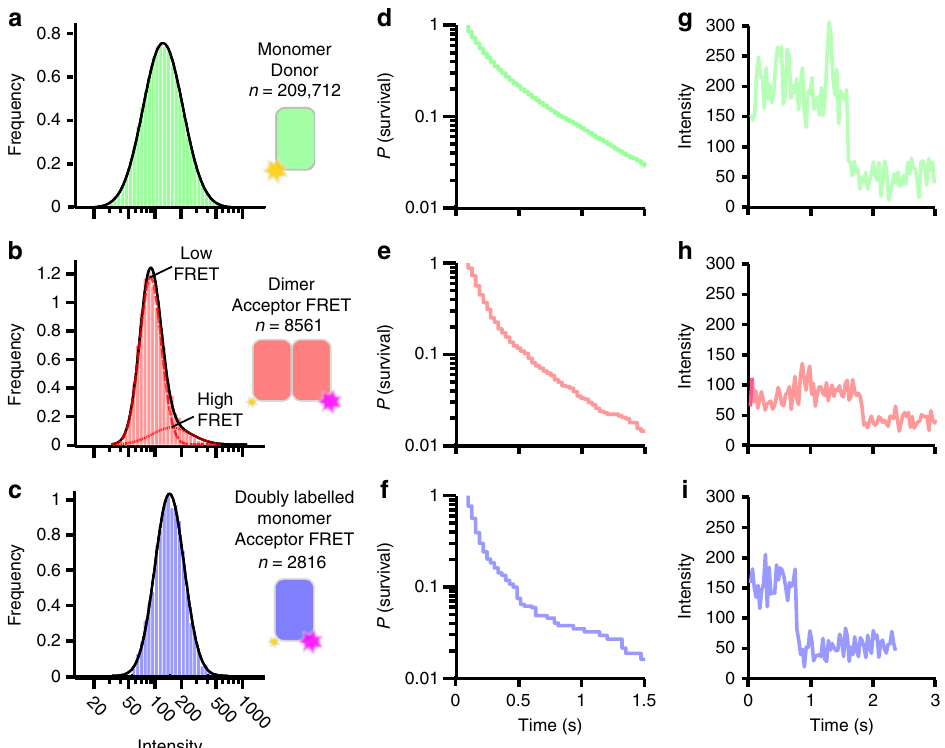
Fig. 2 Single-molecule FRET intensity distributions. The distribution of single particle spot intensities is described well by a single log-normal distribution for a the predominantly monomeric donor spots ( n = 209,712), and c for acceptor spots from a monomeric doubly labelled (TM1 – TM4, Cy3 – Cy5 distance ~1.5 nm) NTS1 control sample ( n = 2816), while for b the FRET acceptor dimer spots it was described by the sum of two log-normal distributions representing high (dotted line) and low (dashed line) FRET dimeric conformations ( n = 8561). Spot lifetime ( d – f ) was similar for all populations indicating dimer lifetime on the order of or greater than the photobleaching timescales. Single-step photobleaching ( g – i ) precludes higher-order oligomers. See also Supplementary Figs. 6, 7, and